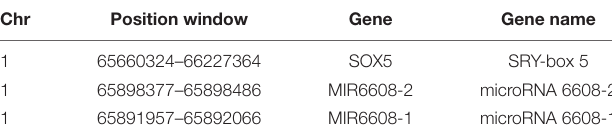
TABLE 6 | List of genes in the identified putative selection signatures among Cochinchina and Brahma Brazilian chicken breeds. Chr Position window